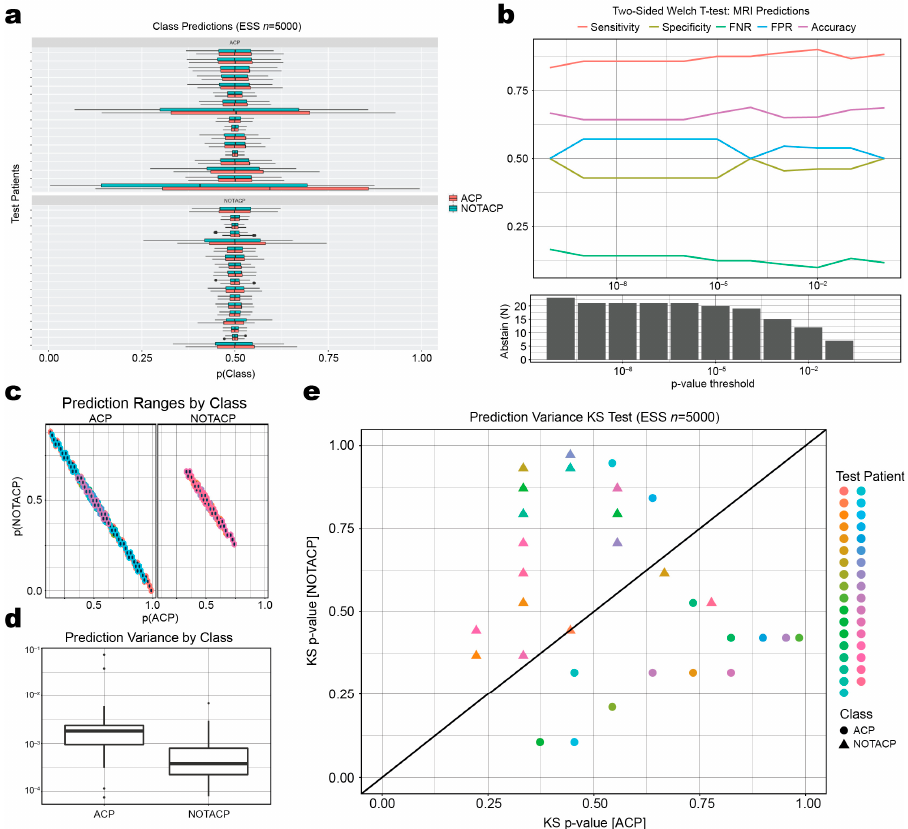
Figure 4. Prediction distributions with mean and variance relationships. ( a ) Predictive distributions (generated using elliptical slice sampling; ESS) stratified by patient ground truth (top APC, bottom NOTACP) and predicted class (red = ACP, blue = NOTACP). ( b ) Model performance using mean values for abstention across p -value threshold. ( c ) Predictive distributions for each diagnostic class, stratified by ground-truth. Colors indicate different patients prodived in the legend in ( e ). ( d ) Boxplot of predictive distribution variance stratified by ground-truth. ( e ) Scatterplot of Kolmogorov-Smirnov p -values for each predicted class. Each point represents one test patient, ACP/NOTACP ground-truth depicted as circles and triangles, respectively. Diagonal line represents classification boundary used in abstention algorithm.